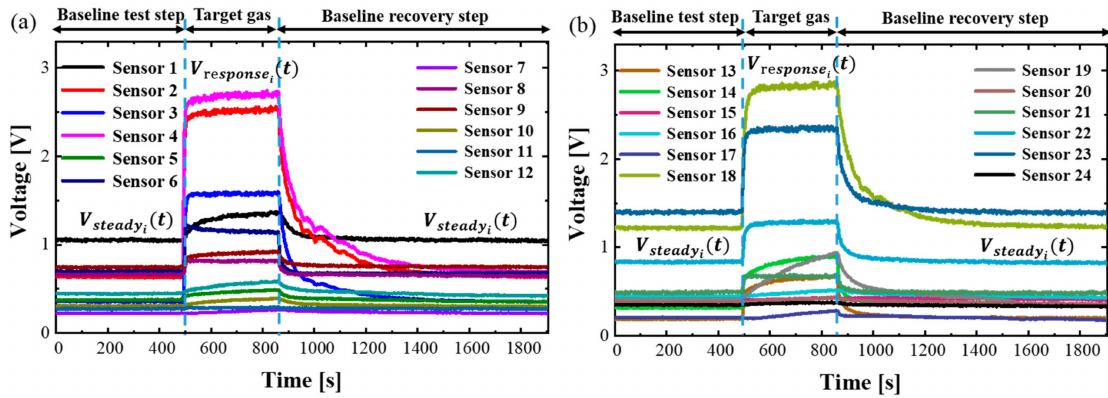
Figure 2. The response curve of 24 gas sensors with 2000 ppm CH4. ( a ) Response curves of the first twelve chemical gas sensors; ( b ) Response curves of the last twelve chemical gas